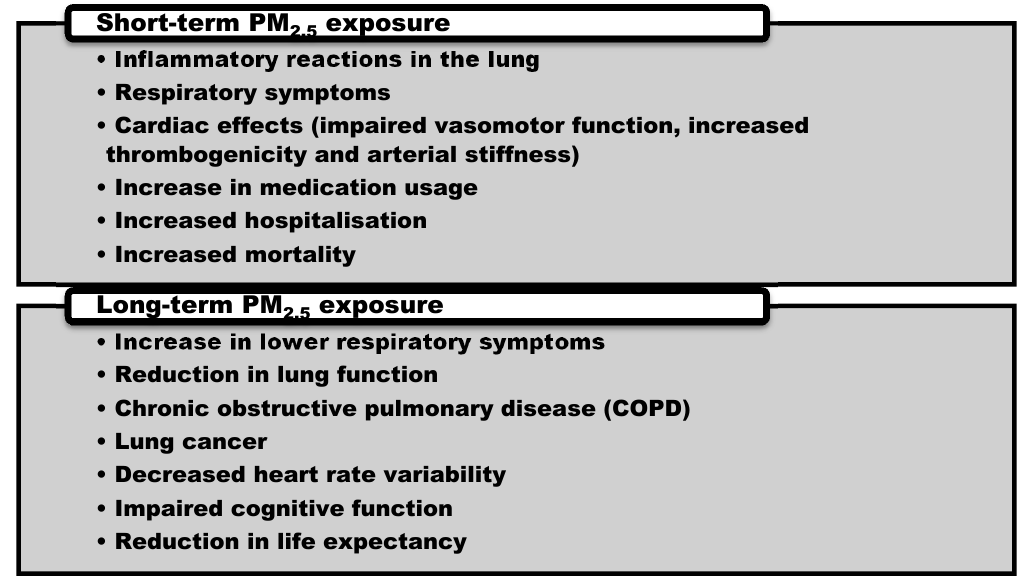
Figure 1. Health effects associated with short ‐ term and long ‐ term fine particulate matter (PM 2.5 ) exposure [37].